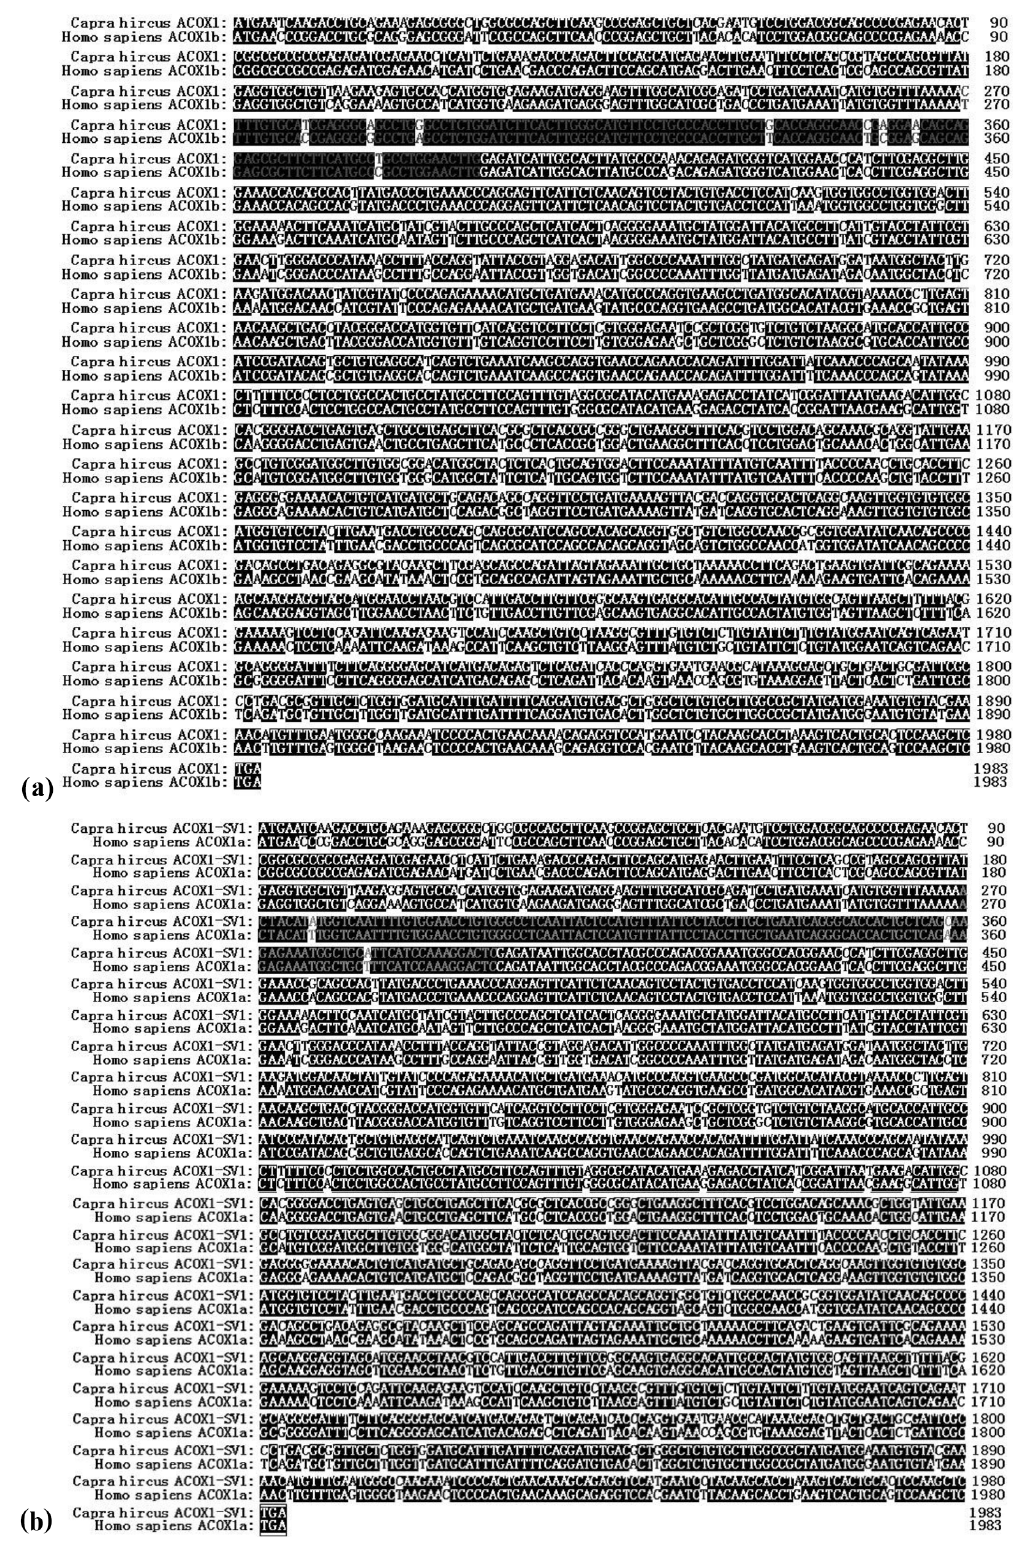
Figure 3. Sequence alignment of ACOX1 transcript variants from goat and human. (a) ACOX1 XM_013972412 is aligned with human ACOX1b NM_004035.6; (b) ACOX1-SV1 KX828848 is aligned with human ACOX1a NM_007292.5). Note: the gray uppercase letters represent the sequence of the novel exon 2 variation event in ACOX1-SV1. Boxes represent the initiation and termination codons.